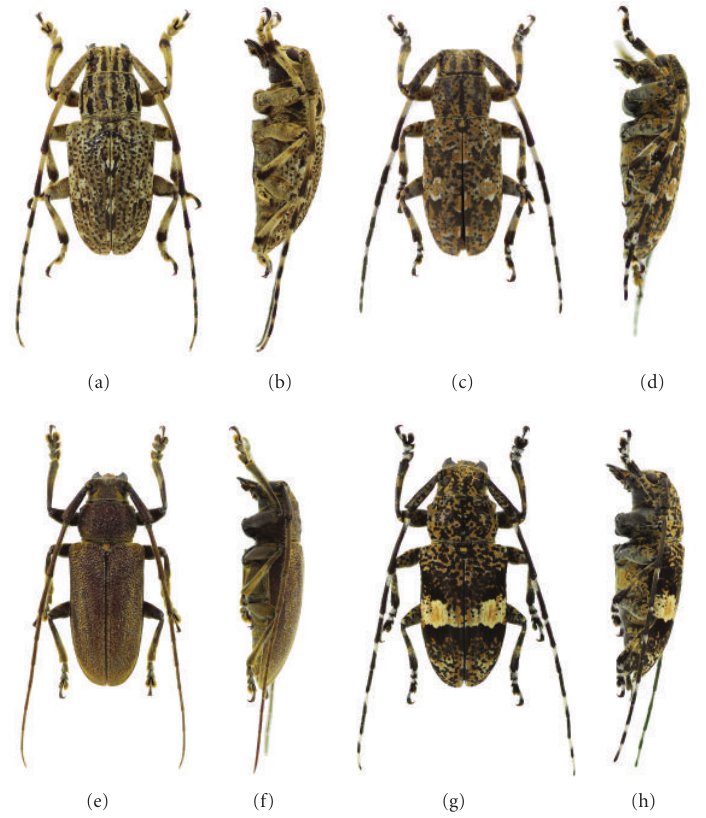
Figure 3: Male habitus of Agelasta ( Dissosira ) spp. (a, b) A. ( D. ) catenata ; (c, d) A. ( D. ) perplexa ; (e, f) A. ( D. ) rufa ; (g, h) A. ( D. ) konoi ; (a, c, e, g) dorsal view; (b, d, f, h) lateral view.